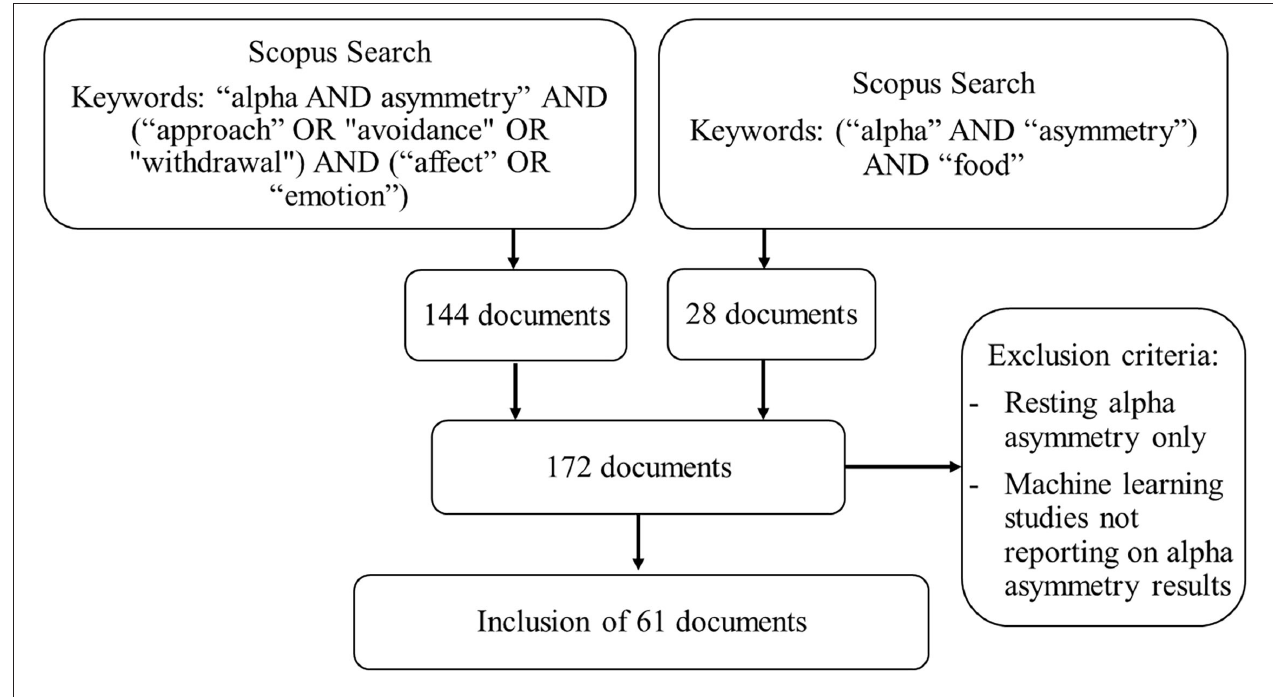
FIGURE 1 | Flow chart of inclusion process for the